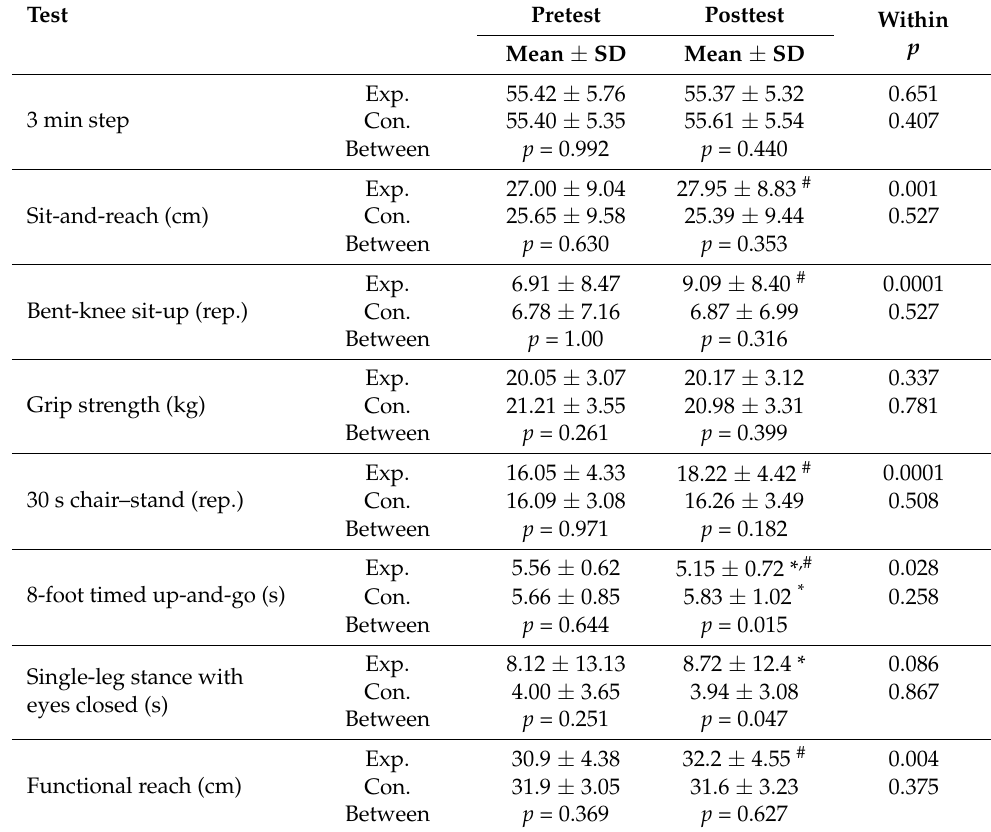
Table 2. Effects of 12-week Pilates program on functional fitness.